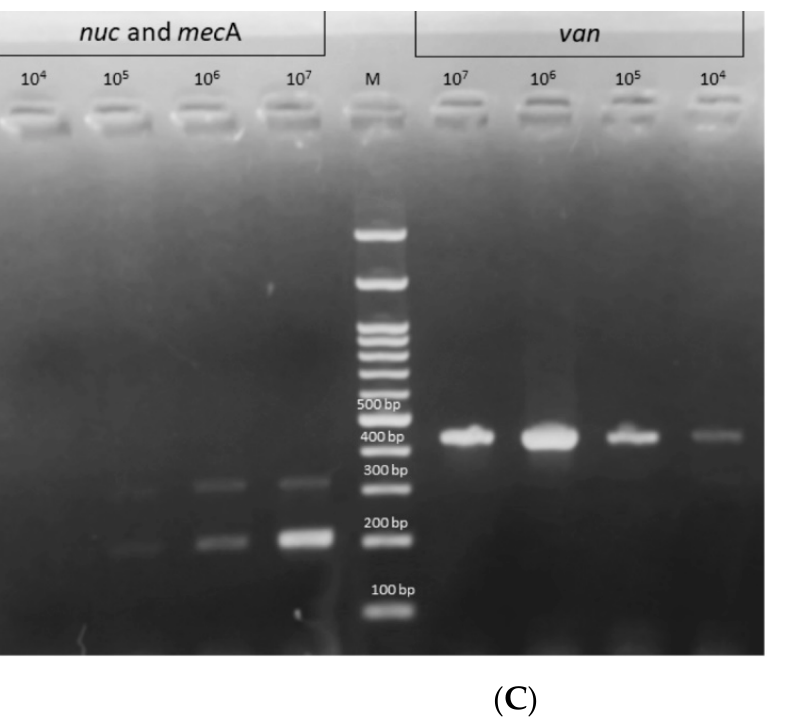
Figure 5. The limit of detection (LOD) of the developed multiplex polymerase reaction (mPCR)- based DNA lateral flow assay (MBDLFA) using the DNA extracted from blood samples artificially inoculated with either Staphylococcus aureus S31 or Enterococcus faecalis E25. The assay successfully detected: ( A ) S. aureus ( nuc ) and methicillin resistance ( mec A) in S31 with LODs of 10 7 CFU/mL and 10 8 CFU/mL, respectively, using the designed chromatography-printed assay strip (C-PAS), and ( B ) vancomycin resistance ( van A/B) in E25 with an LOD of 10 4 CFU/mL, using the designed C-PAS. ( C ) The products were visualized on a 1.5% agarose gel stained with ethidium bromide, the LODs of the assay from artificially inoculated blood samples was 10 5 CFU/mL for both the nuc and mec A genes and 10 4 CFU/mL for the van A/B genes. The red lines on the strips in ( A , B ) represent position markers that help the localization of test lines.